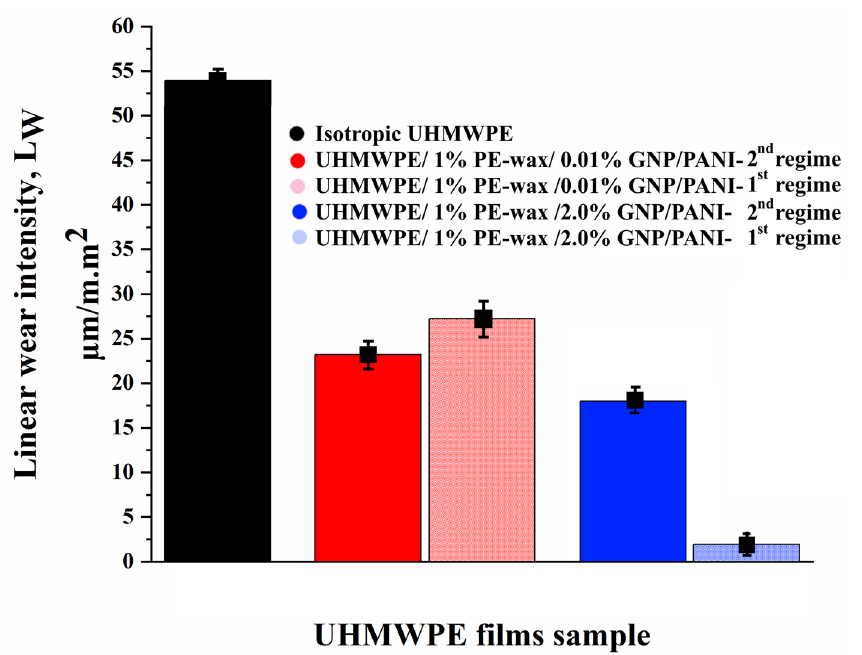
Figure 13. Linear wear intensity for UHMWPE/1.0% PE-wax/GNP/PANI films obtained by second thermal orientation regime in comparison with the films obtained by the second regime.